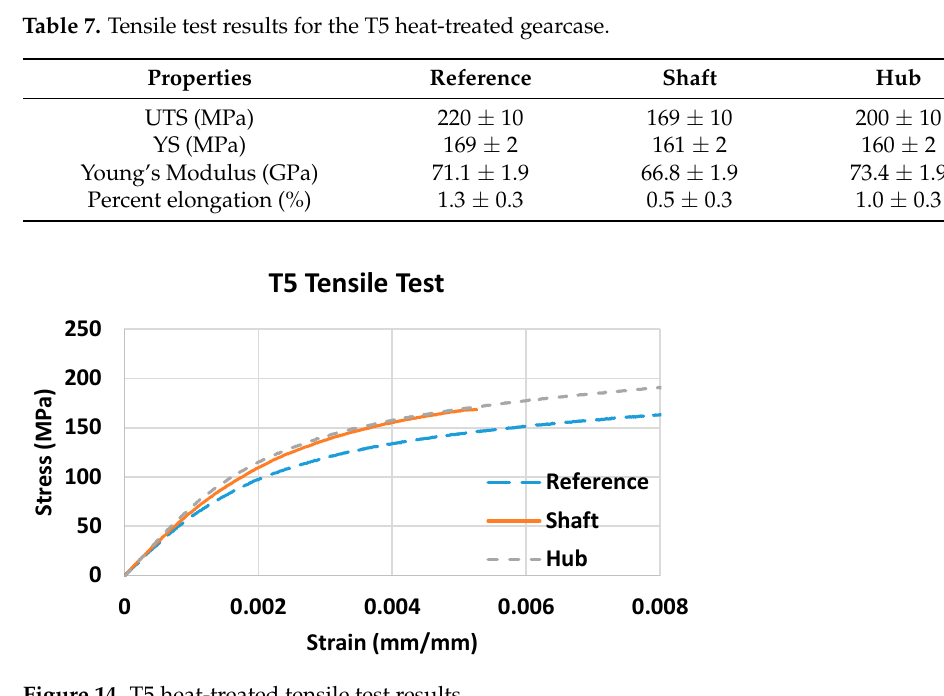
Figure 14. T5 heat-treated tensile test results.